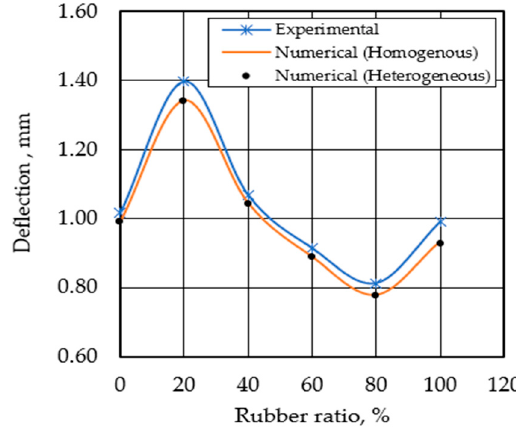
Figure 9. Deflection versus rubber content relationships of all the concrete beam models.